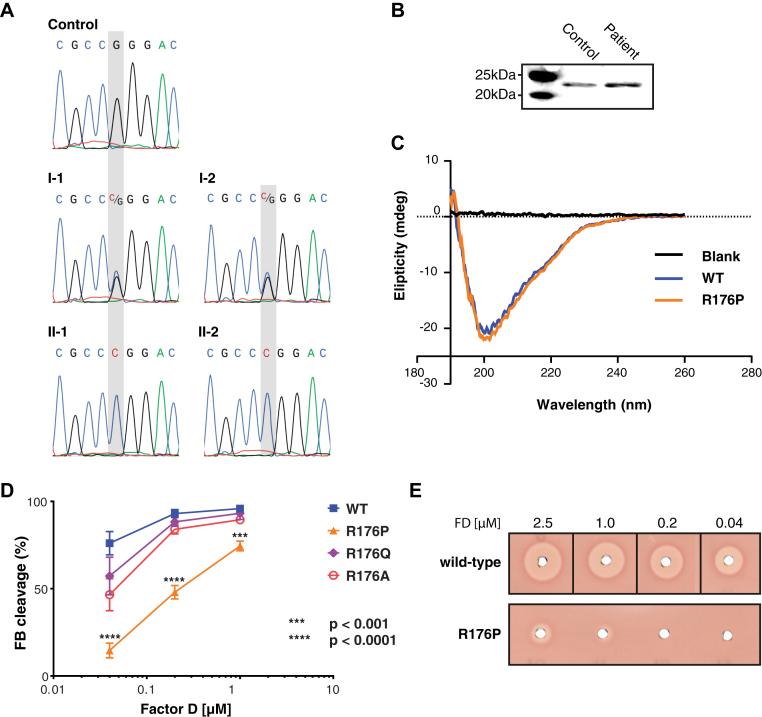
Mutation R176P results in a type III FD deficiency. A, Chromatograms for the DNA sequence adjacent to position c.602 are shown for each member of the pedigree. The identified variant is rare: the Exome Aggregation Consortium's ExAC database reports mutation R176P (variant 19:861943 G/C) at an allele frequency of 1.049 × 10−4, with no homozygotes.E9B, Western blot analysis of FD in serum from the patient and healthy control. C, Secondary structural compositions of WT and R176P FD were evaluated using circular dichroism spectroscopy. D, Comparison of in vitro catalytic activity of recombinant WT, R176P, R176Q, and R176A FD in terms of FB cleavage. ***P < .001; ****P < .0001. E, Recombinant WT and R176P FD were tested for the ability to reconstitute AP50 when added to FD-depleted serum.